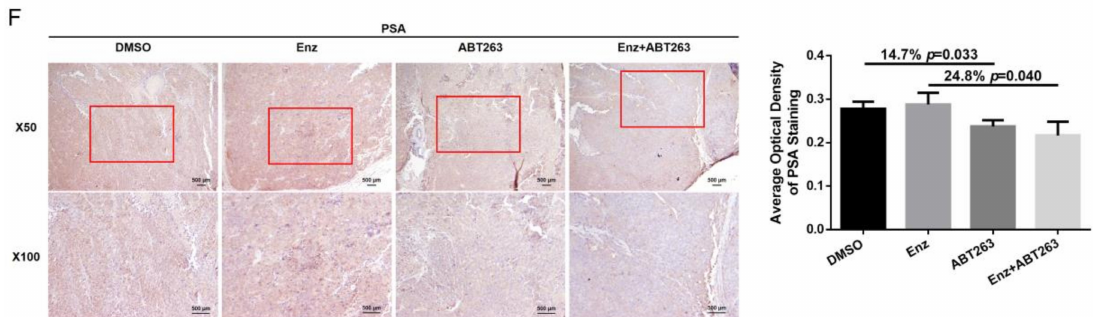
Figure 7. Preclinical study using in vivo mouse model to demonstrate ABT263 increases Enz sensitivity in Enz-resistant PCa cells (EnzR3-CWR22Rv1) and better suppress of PCa progression. ( A , B ) ABT263 increases Enz sensitivity and decreases xenograft tumor size. Xenograft tumors from mice after 4–5 weeks’ drug treatment were displayed ( A ). Tumor size was measured every week after drug delivery and reduction of the xenografts was observed in Enz with ABT263 treatment group ( B ). ( C ) Mice weight before and after drug treatment was comparable; ( D – F ) ABT263 decreases AR, ARv7, and PSA expression in xenograft tumors. Representative immunohistochemistry (IHC) images of AR in xenograft tumors ( D ), of ARv7 in xenograft tumors ( E ), and of PSA in xenograft tumors ( F ). Average optical density of staining was calculated using ImageJ software. Data are presented as Mean ±